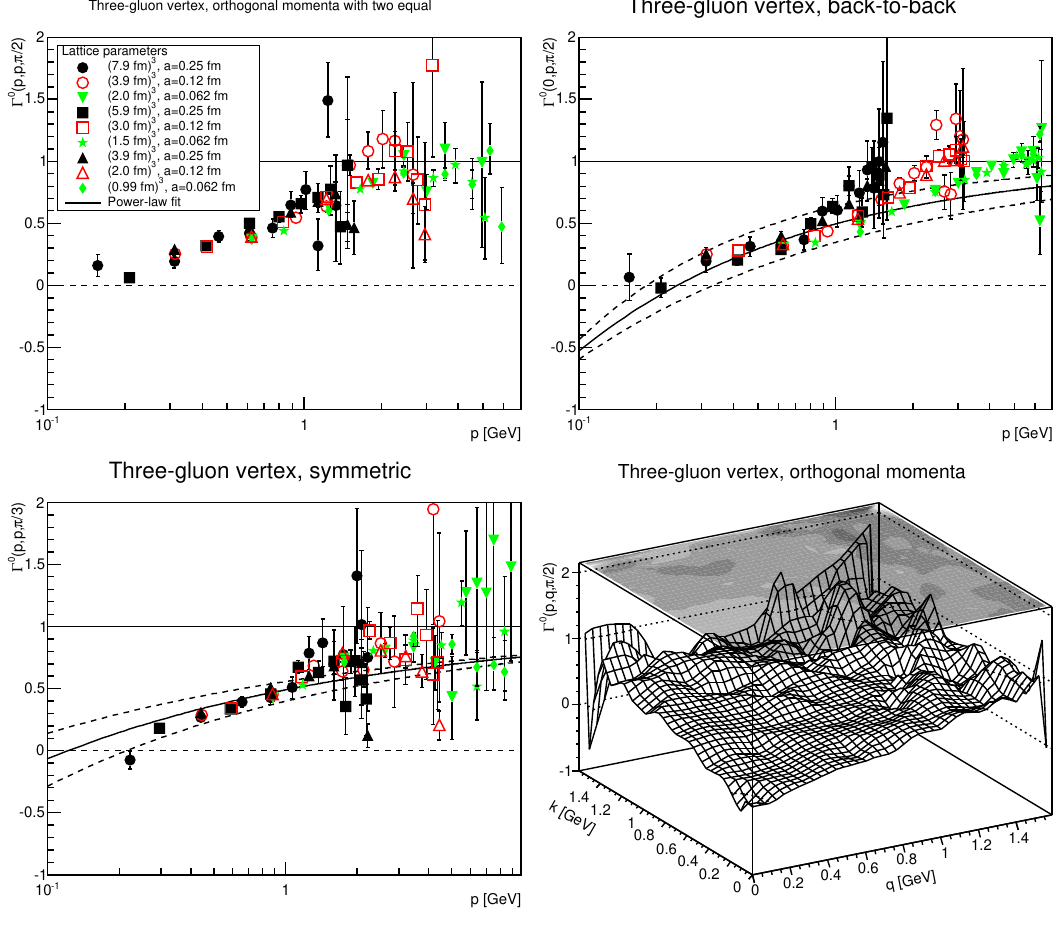
Figure 5: Same as in figure 1, but in four dimensions and the lowest momentum point is